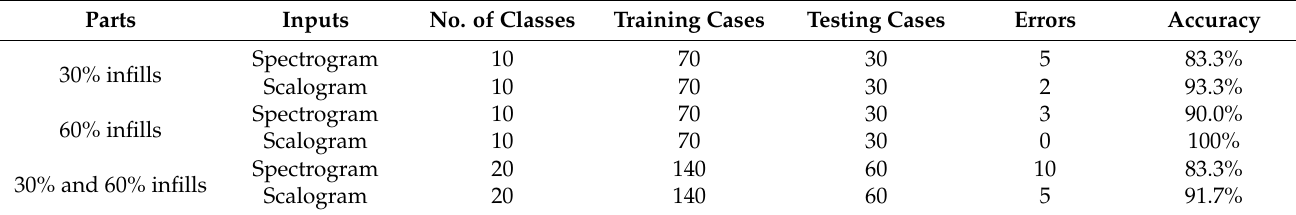
Table 2. Classification results for 3D printed parts with